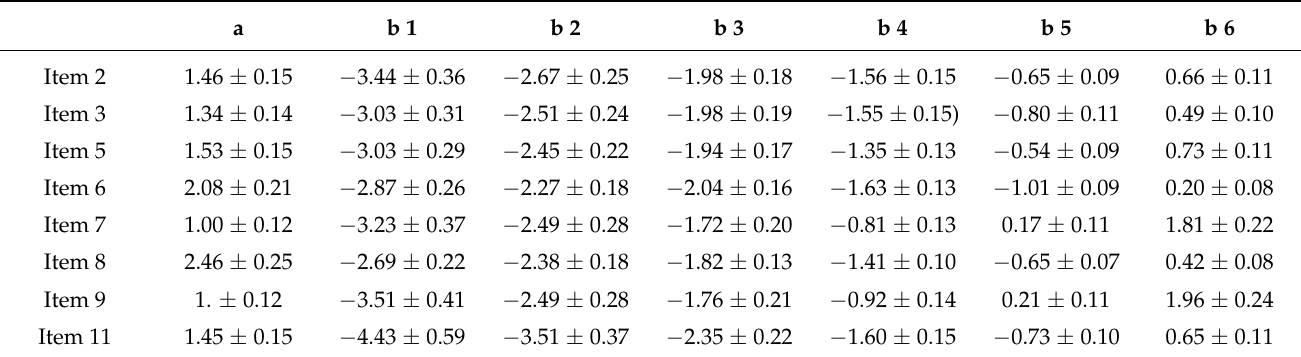
Table 6. IRT parameterization of the WSCS items: item discrimination and item difficulty measures with related standard